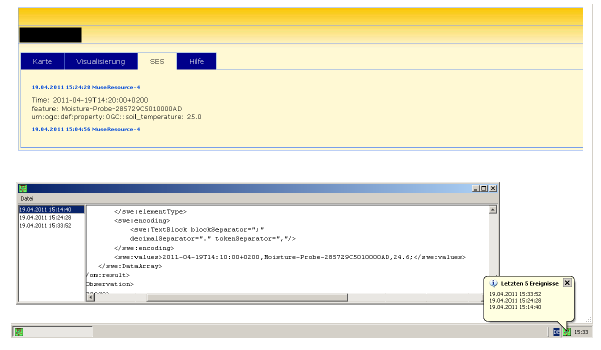
Figure 10. Extended Web client and